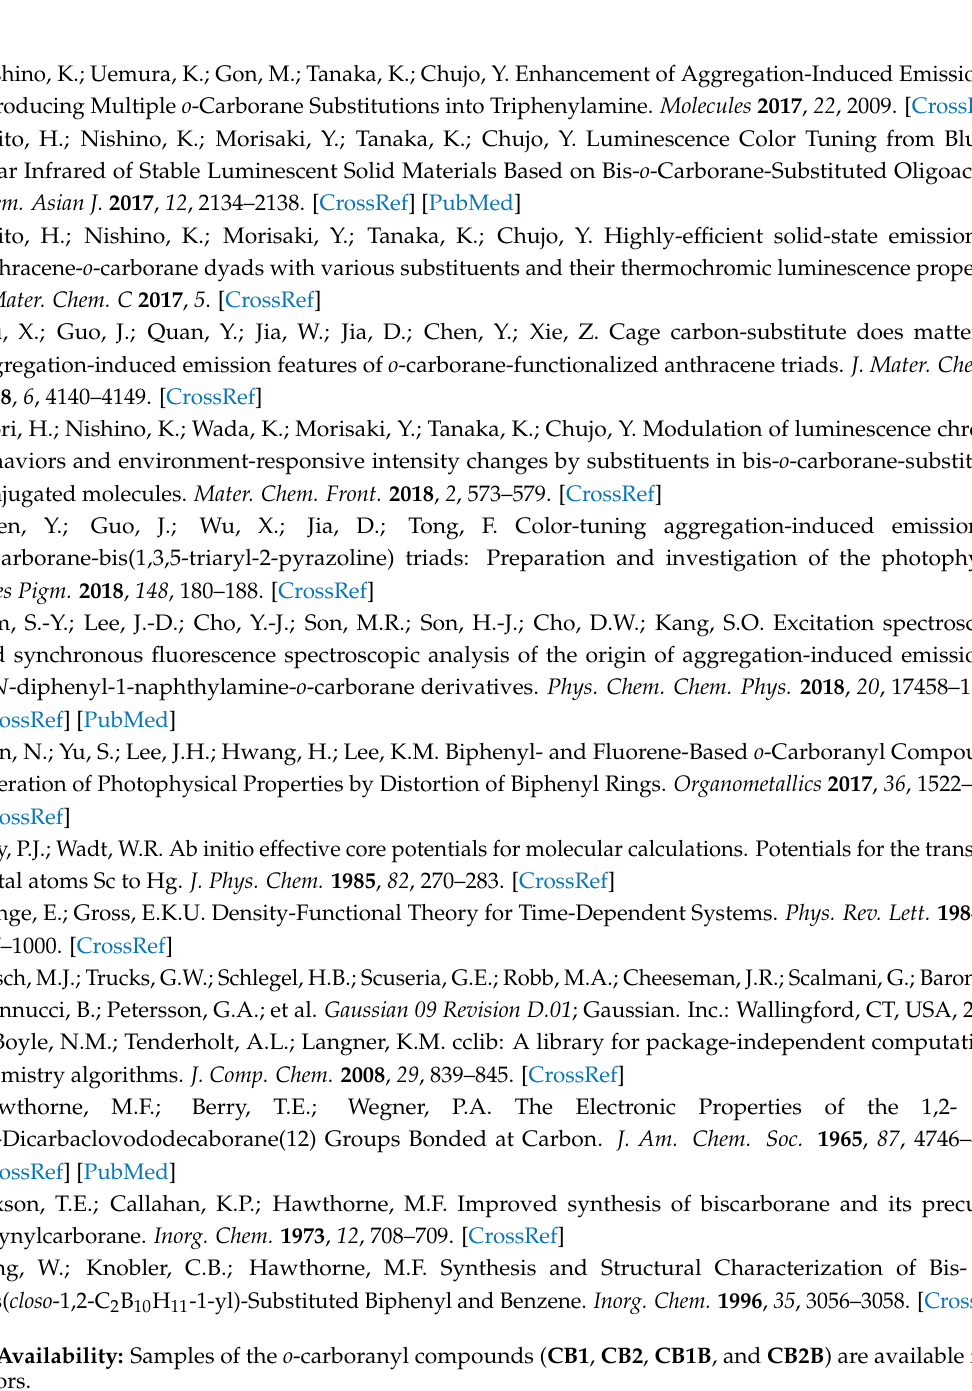
Sample Availability: Samples of the o -carboranyl compounds ( CB1 , CB2 , CB1B , and CB2B ) are available from the